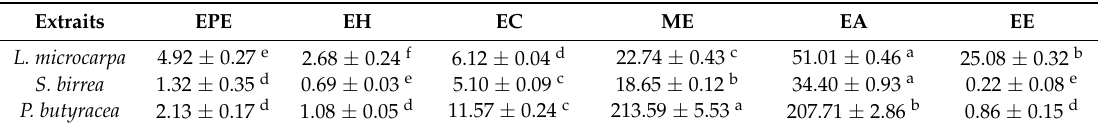
Table 3. Reduction power of the extracts on ferric ion (expressed as mg